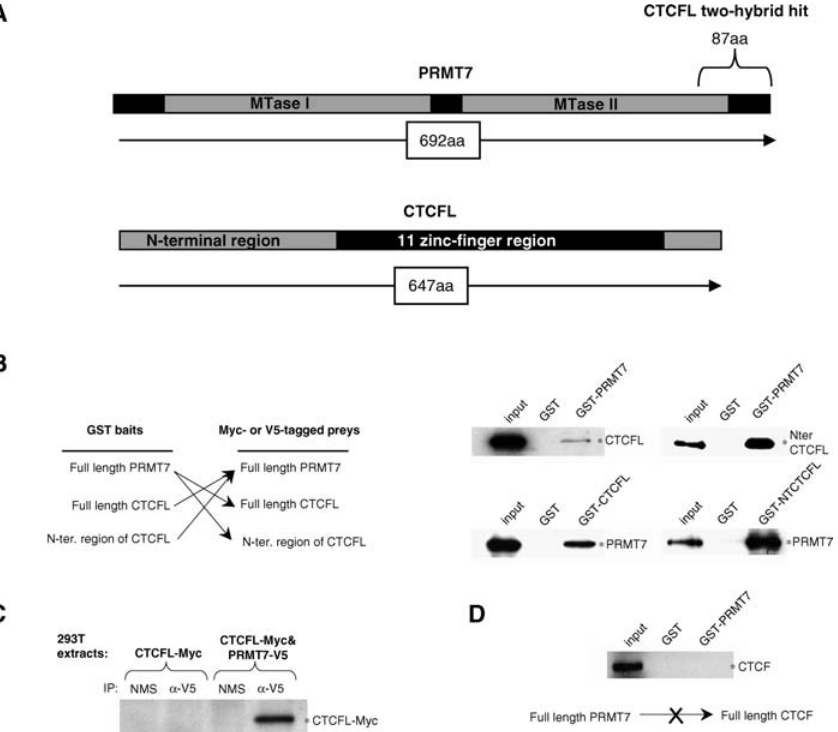
Figure 3. N-terminal CTCFL Interacts with PRMT7 (A) Diagrams show the domain structure of the PRMT7 and CTCFL proteins. MTase I and II represent the methyltransferase regions within PRMT7. The position of the recovered yeast two-hybrid clone of PRMT7 is indicated. (B) Reciprocal GST pull-downs of CTCFL and PRMT7. Scheme of the tested interactions is given in diagrams. GST and GST fusion proteins (CMV-GST vector) were co-expressed in 293T cells with myc- or V5-tagged preys. N-ter., N-terminal. (C) Co-immunoprecipitation of CTCFL and PRMT7. The 293T extracts containing over-expressed CTCFL-Myc or CTCFL-Myc&PRMT7-V5 were immunoprecipitated with a -V5 antibody or normal mouse serum (NMS). CTCFL was detected with a -Myc antibody. N-ter., N-terminal. (D) No interaction between CTCF and PRMT7 is detectable by GST pull-downs. DOI: 10.1371/journal.pbio.0040355.g003